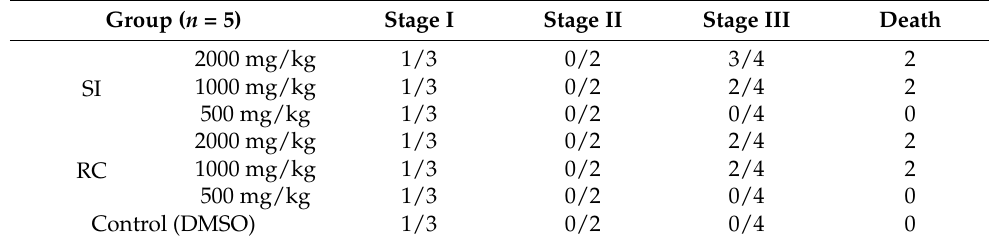
Table 1. Effect of the treatments on the behavior and